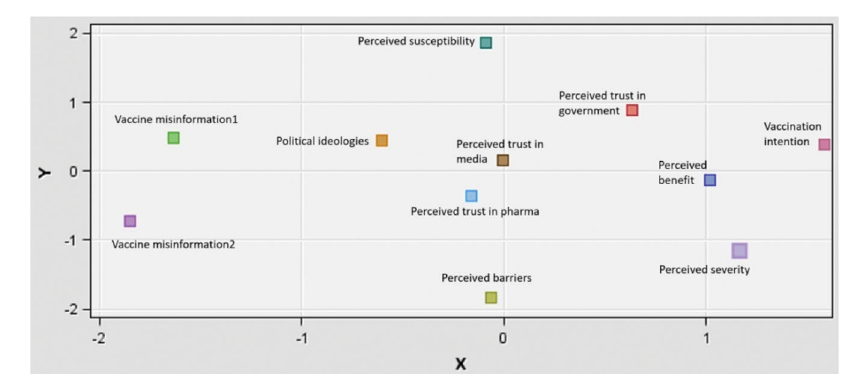
Fig. 4 Cartesian plot of cluster distances. The identi fi ed clusters were plotted according to the distance generated from a cluster algorithm.